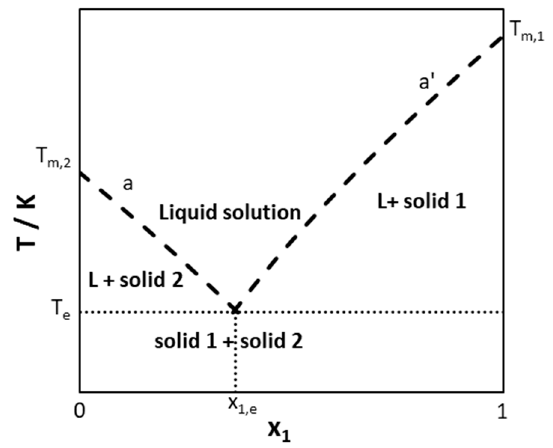
Figure 1. Schematic representation of a solid–liquid phase diagram of a simple eutectic system.